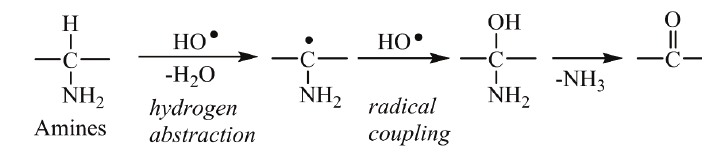
Figure 2. Degradation scheme of amine ( 1 ) by HO •